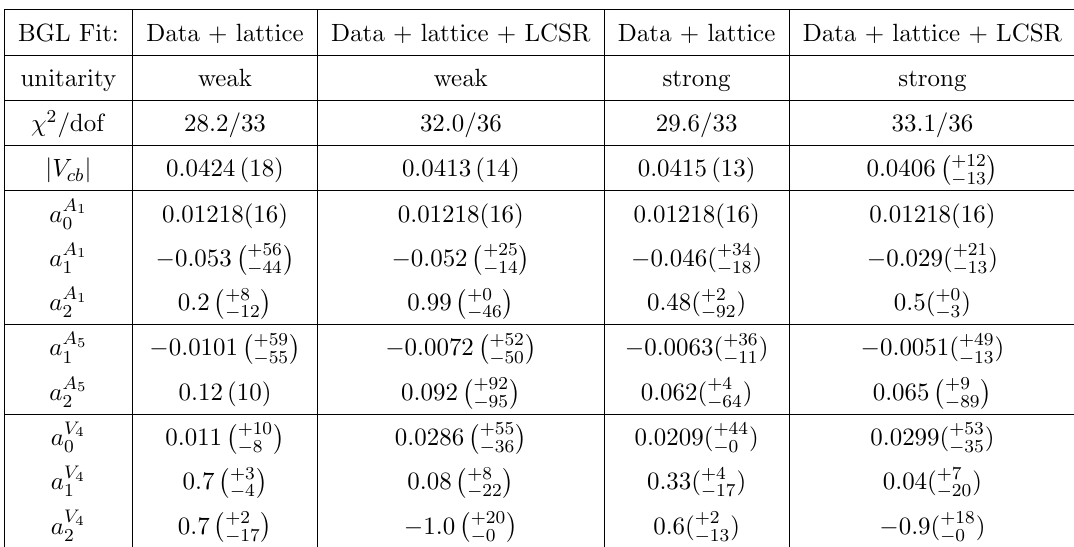
Table 5 . Fit results using the BGL parametrization with N = 2 without and with the strong unitarity constraints. In the BGL (cid:12)ts a A 5